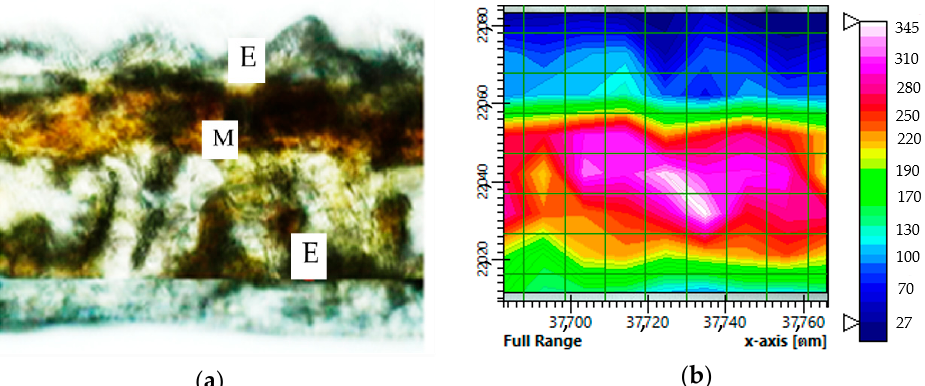
Figure 1. Chemical composition area maps of part of a transverse leaf section from a rubber tree, which was achieved using Fourier transform infrared (FTIR) microspectroscopy point to point mapping with aperture setting at 15 × 15 μ m steps. ( a ) A micrograph of a rubber tree plantation. ( b ) Integrated mapping of chemical composition, obtained over the spectral region of 4000–900 cm − 1 . E, Epidermis; M, Mesophyll.